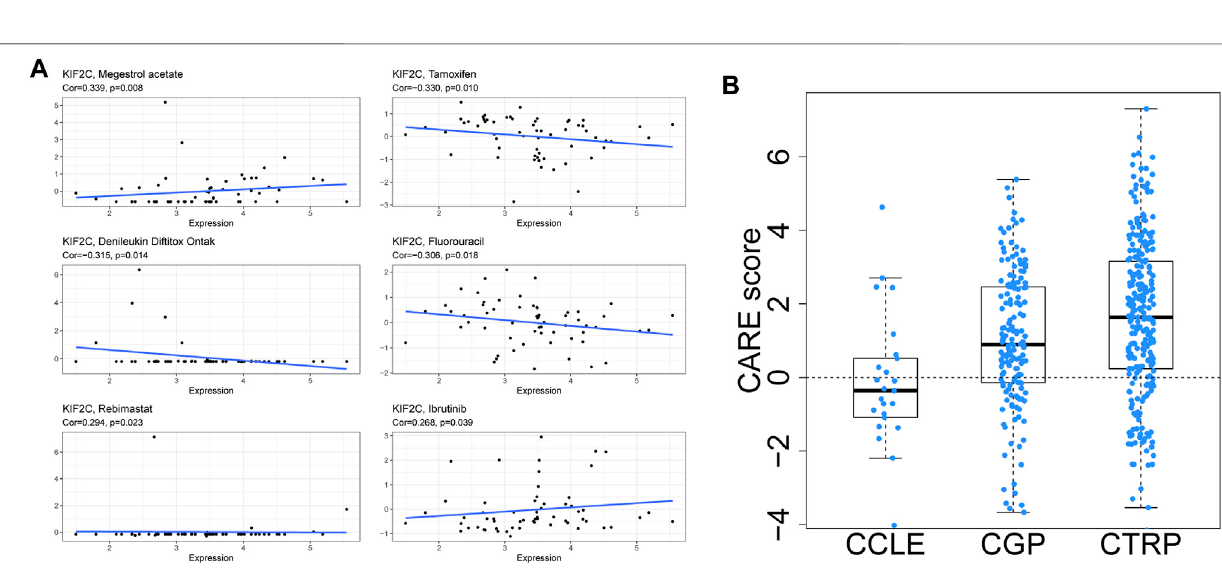
Frontiers in Genetics |